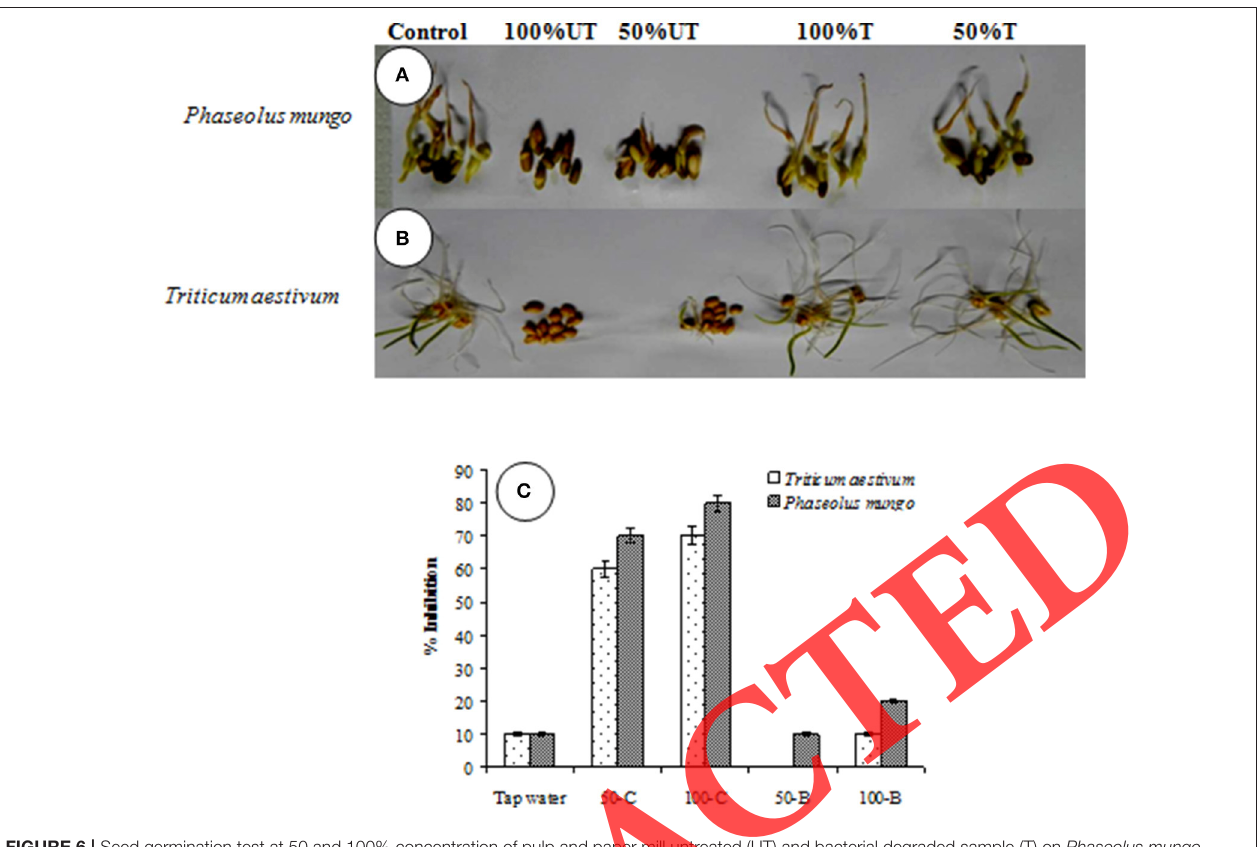
FIGURE 6 | Seed germination test at 50 and 100% concentration of pulp and paper mill untreated (UT) and bacterial degraded sample (T) on Phaseolus mungo (A) and Triticum aestivum (B) and percent inhibition of seed germination (C)